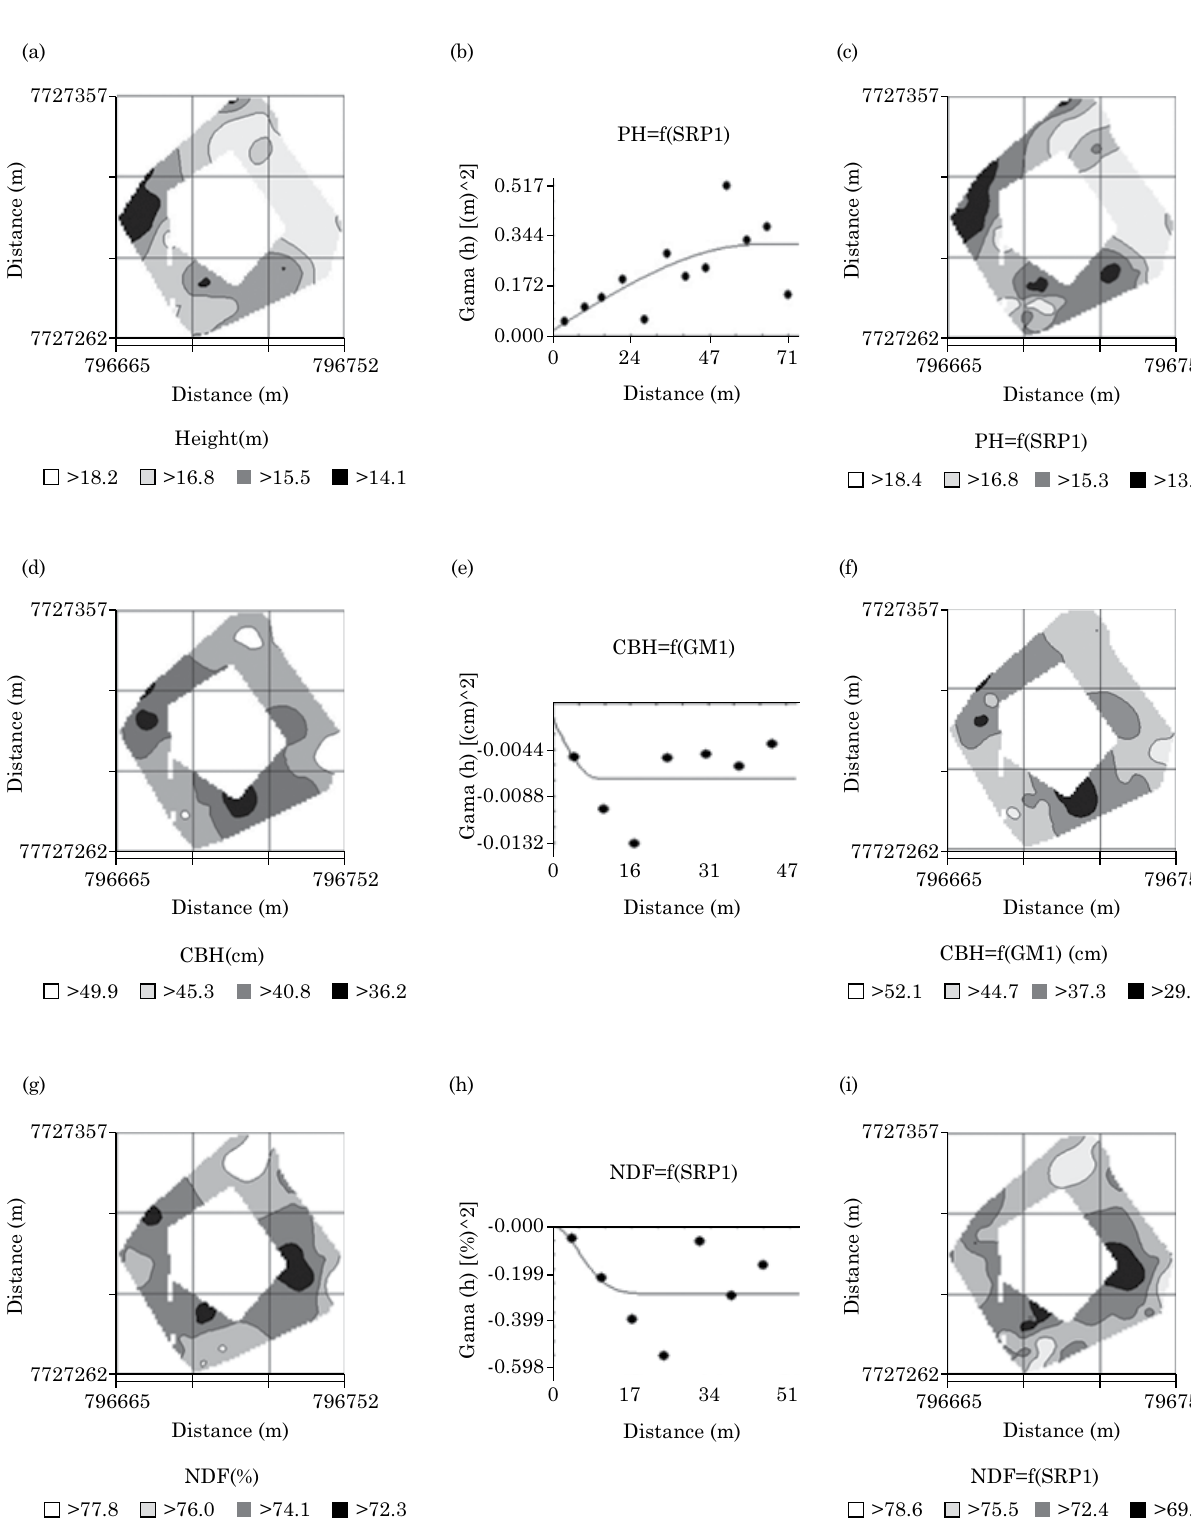
Figure 1. Kriging map, cross semivariogram and co-kriging map for eucalyptus plant height (PH) in relation to resistance to penetration, 0.00-0.10 m (SRP1); circumference at breast height (CBH) in relation to gravimetric moisture, 0.00-0.10 m (GM1), and neutral detergent fiber (NDF) in relation to resistance to penetration, 0.00-0.10 m (SRP1) in a Quartzipsamment (Entisol) soil in a silvopastoral system in Ribas do Rio Pardo, MS,